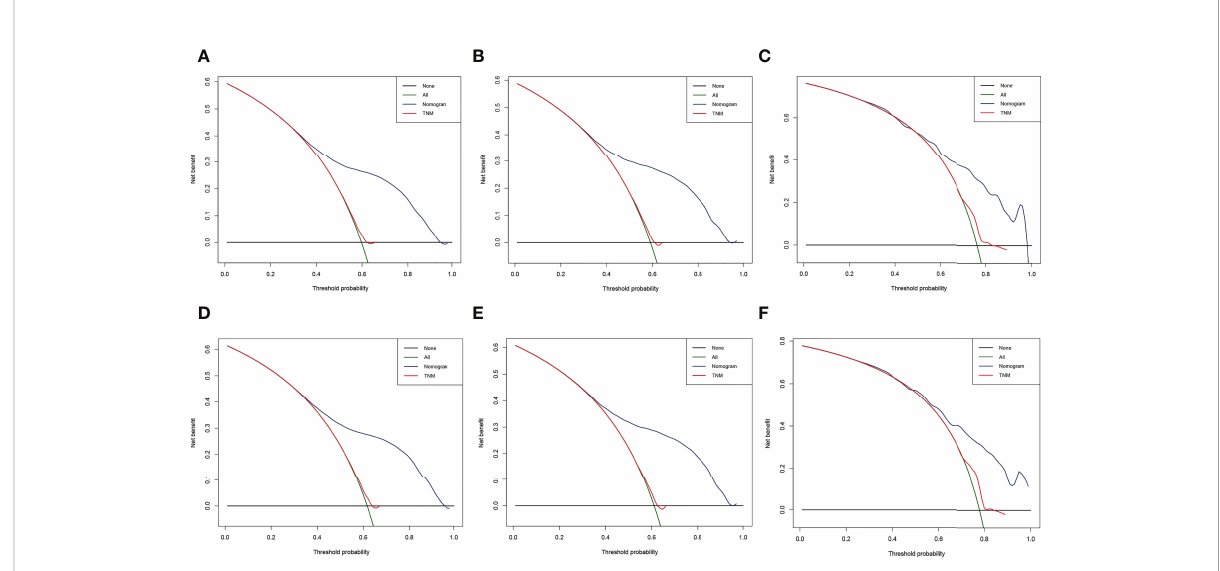
FIGURE 9 Decision curve analysis (DCA) of the nomogram and TNM stage for the overall survival (OS) and cancer-speci fi c survival (CSS) prediction of patients with lung cancer with bone metastasis (LCBM). (A) The training, (B) internal validation, and (C) external validation cohorts for the OS.